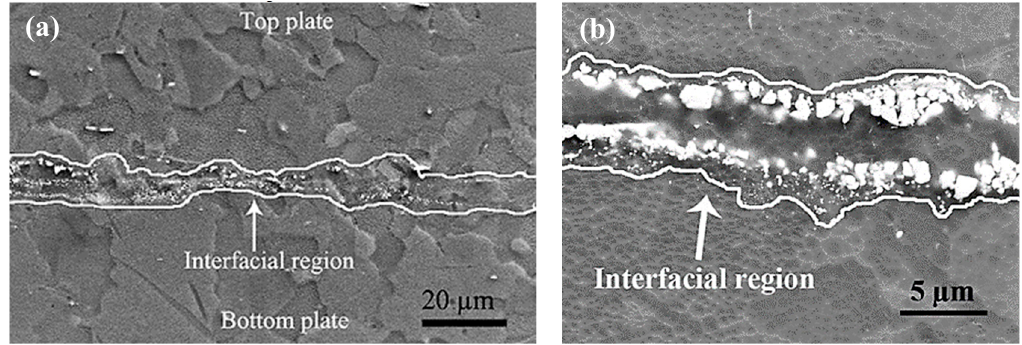
Figure 11. Interface SEM observation of joint type B (1100 J), ( a ) low magnification; ( b ) high magnification.